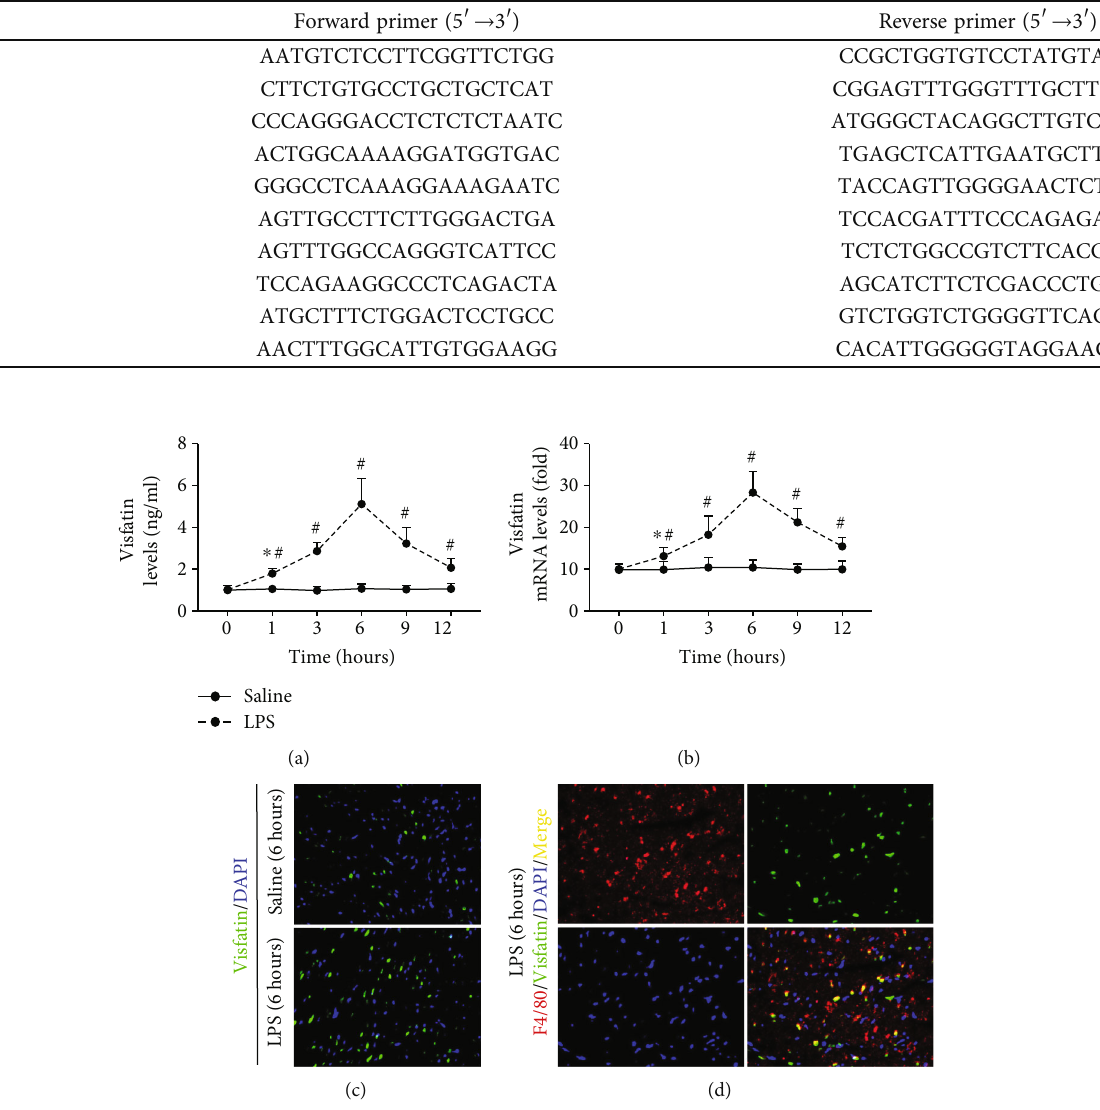
Figure 1: Expression of visfatin in septic mice. (a and b) Dynamic changes in visfatin levels in the serum and heart were detected in mice with LPS-induced septicemia. (c) Cardiac visfatin expression was detected in saline- and LPS-treated mice (200 × ). (d) Visfatin expression in cardiac macrophages was detected (200 × ). N = 5 in each group. ∗ p < 0 : 05 vs. the saline group. # p < 0 : 05 vs. the previous